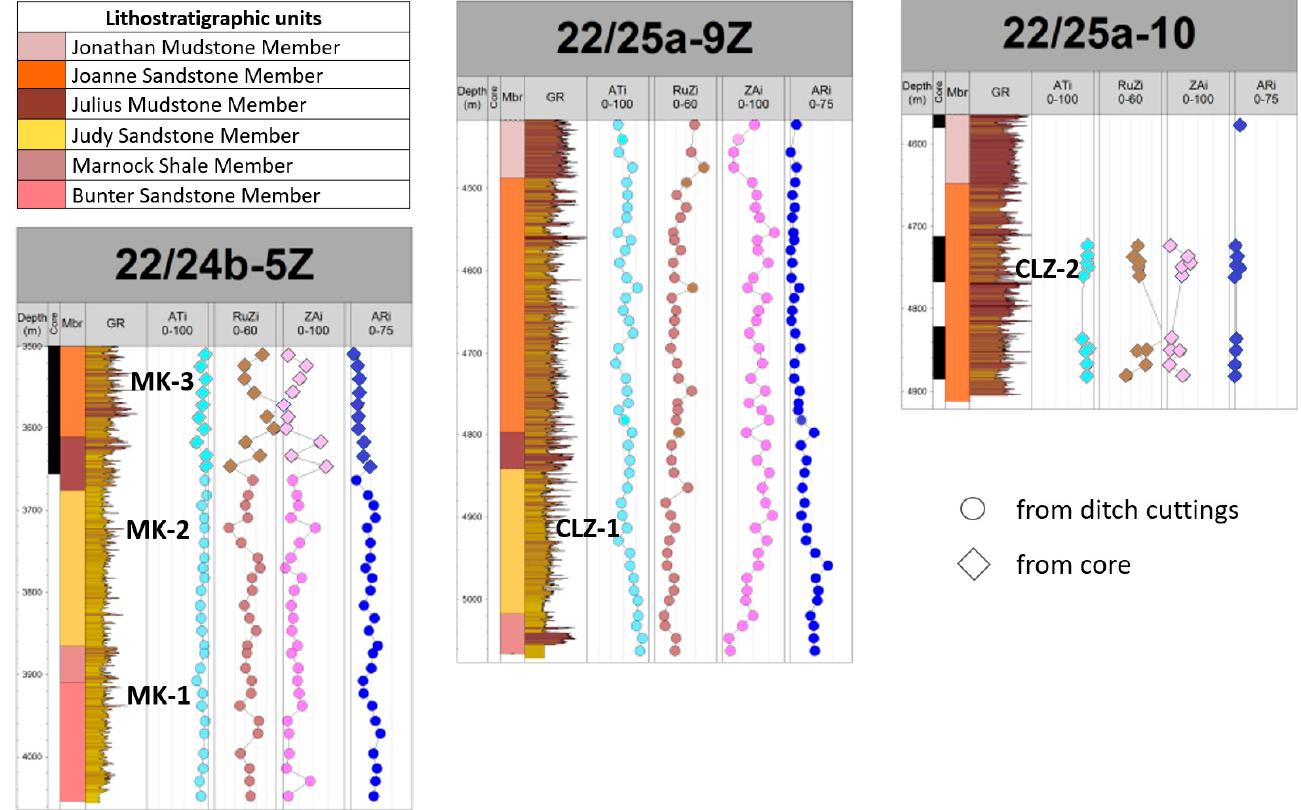
Figure 3. Stratigraphic variations in key heavy mineral parameters for the Triassic in the three wells discussed in this paper, showing locations of samples with zircon and apatite isotopic and trace element data. Profiles are based on data from Greig [66], consistent with previous results of Mouritzen et al. [16]. ATi = apatite:tourmaline index, RuZi = rutile:zircon index, ZAi = zircon:apatite index, ARi = apatite roundness index; see Morton and Hallsworth [67], Morton et al. [68] and Mour- itzen et al. [16] for definitions. MK-1, MK-2, MK-3, CLZ-1 and CLZ-2: see Supplementary Materials.